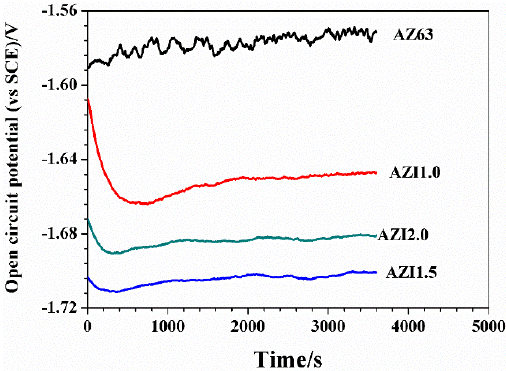
Figure 5. The variation of open circuit potential (OCP) for AZ63 and AZI alloys in 3600 s in 3.5 wt% NaCl at 25 ± 1 °C.